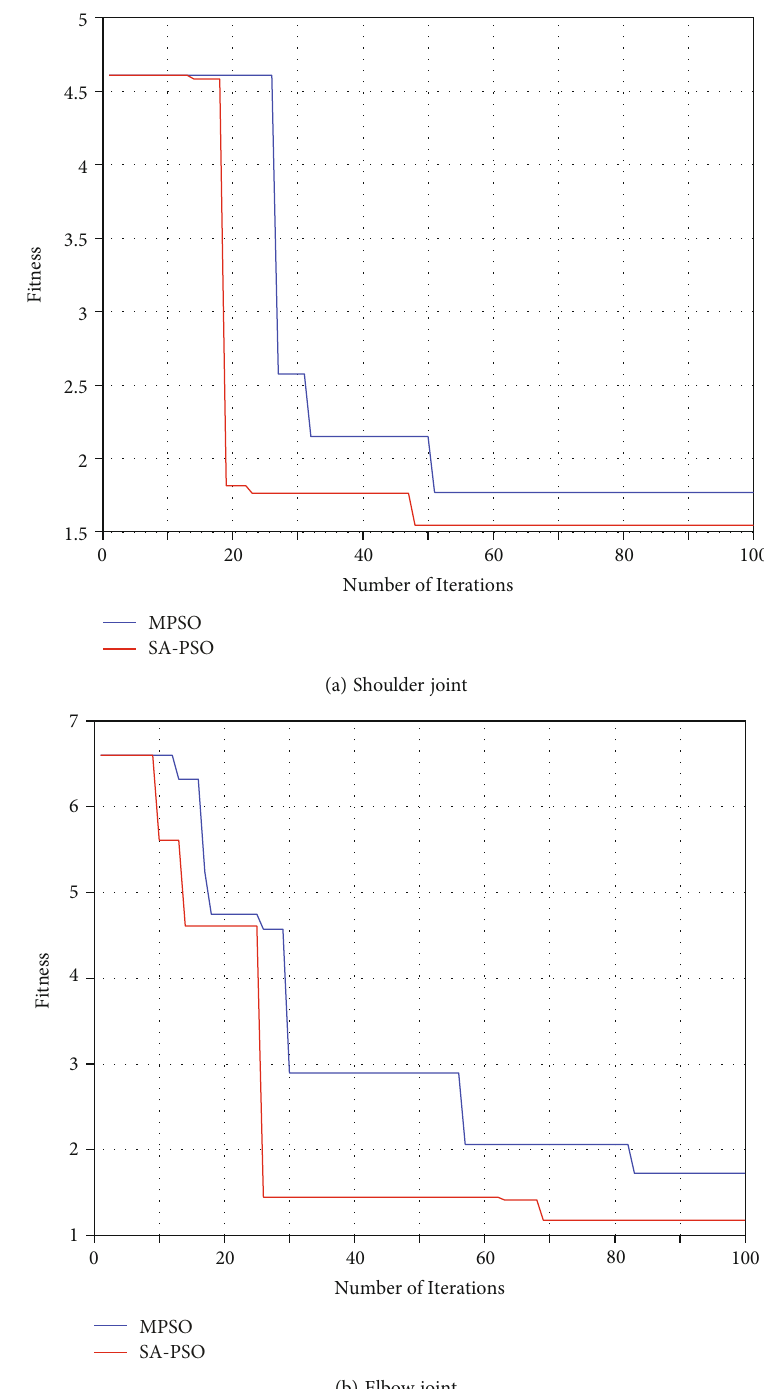
Figure 4: Comparison of fi tness values between the SA-PSO algorithm and the MPSO